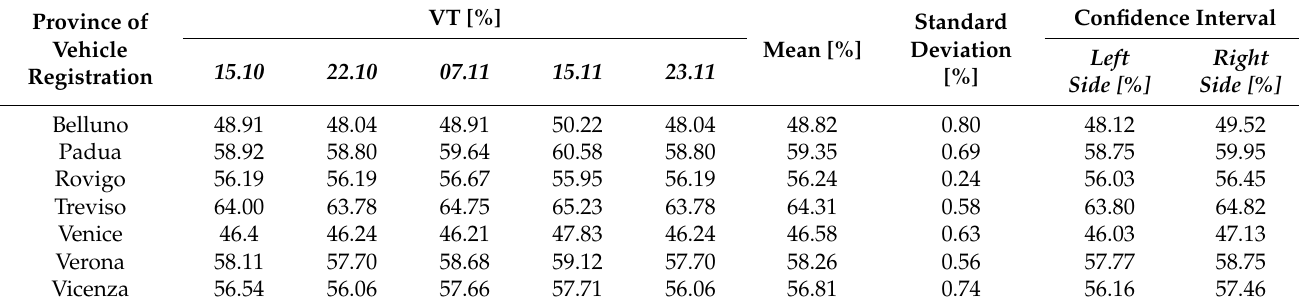
Table 8. Data on VT values for the observation days.